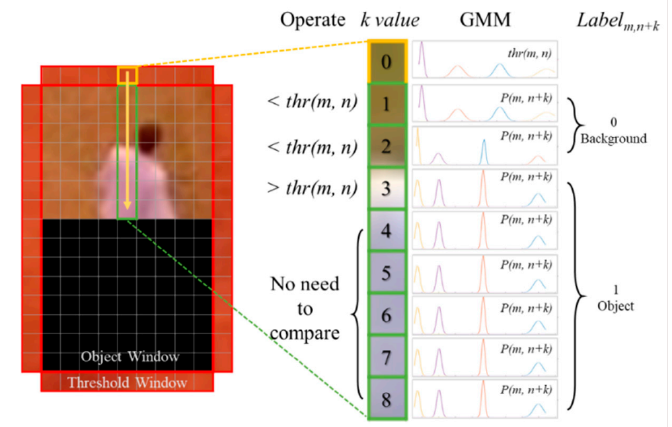
Figure 7. Object marking and difference characteristic